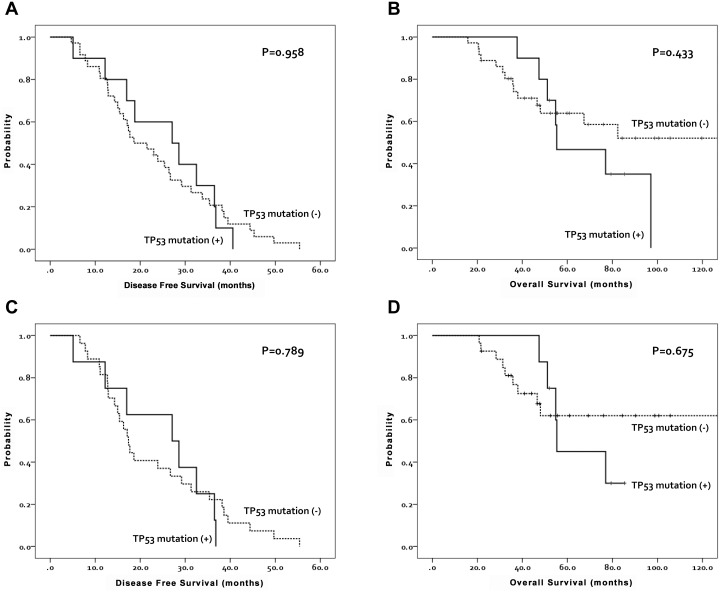
Comparison of disease-free-survival and overall survival with respect to TP53 mutation.Disease-free-survival and overall survival are not different between TP53 mutation-negative group and TP53 mutation-positive group. A and B, Disease-free-survival and overall survival in total EOC patients (n = 46, 36 TP53 mutation (−) vs. 10 TP53 mutation (+)). C and D, Disease-free-survival and overall survival in serous adenocarcinoma (n = 35, 27 TP53 mutation (−) serous vs. 8 TP53 mutation (+) serous).